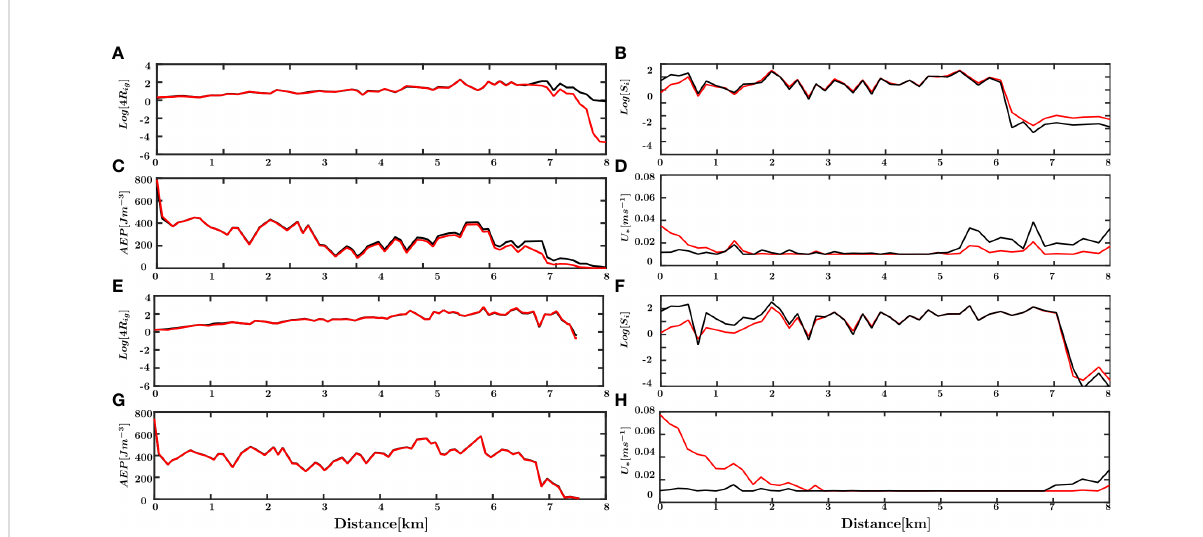
FIGURE 10 Gradient Richardson number normalized for the dry season 2018 (A) and 2020 (E) . Simpsons number averaged over the spring tidal cycle for the dry season of 2018 (B) and 2020 (F) , potential energy anomaly averaged over the spring tidal cycle for 2018 dry season (C) and 2020 (G) . (Without waves in black and with waves in red). and bottom shear velocity averaged over the spring tidal cycle for 2018 dry season (D) and 2020 (H)